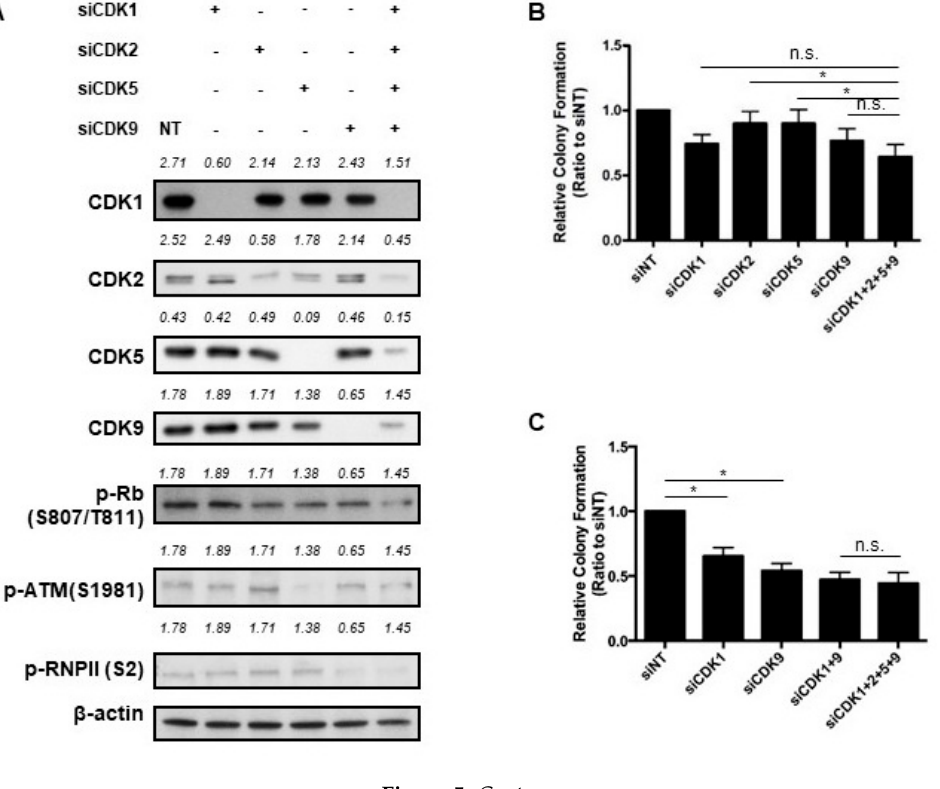
Figure 5. Cont. Figure 5.